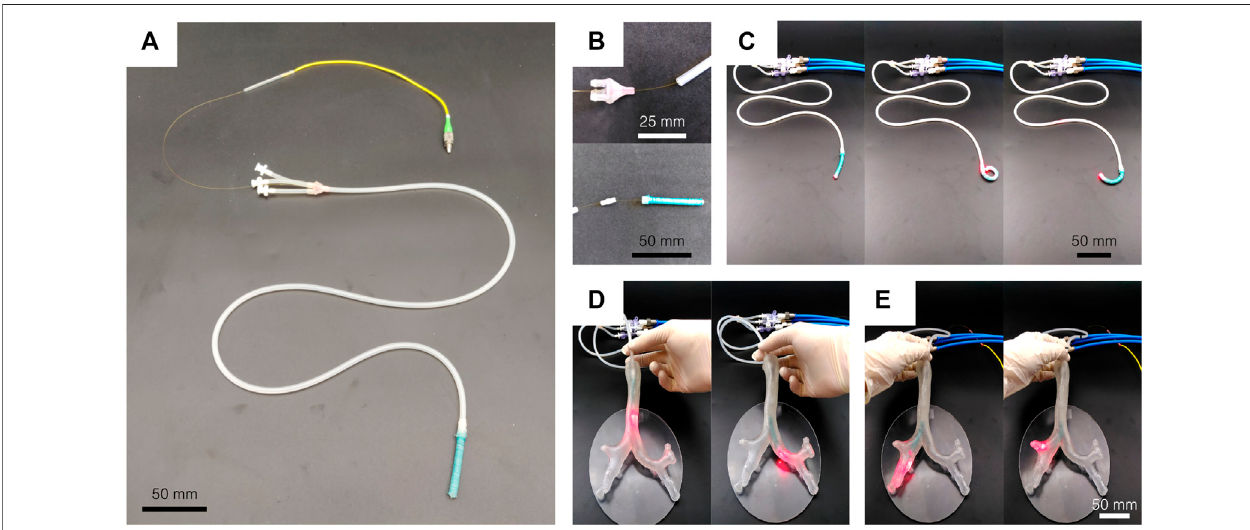
FIGURE 10 | Steerable catheter demonstrator. (A) A soft active tip is assembled on an 85 cm long extruded segment, and an optical fi ber is placed in the working channel. (B) 3D printed connectors are used to assemble the segments. (C) The actuator is still able to bend in every direction and to reach high curvature. (D) The steerablecathetercanbeinsertedinabronchialtreephantomandallowstonavigatebybendingthetipinthedesireddirection. (E) Thetertiarybronchioftherightupper lobe can easily be illuminated by the light transmitted by the optical fi